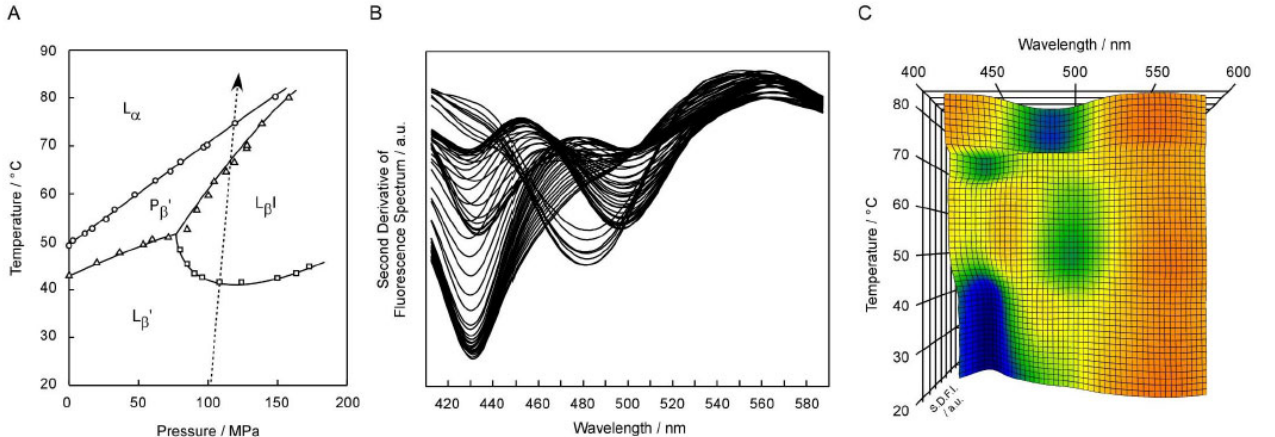
Figure 1. ( A ) Temperature ( T )–pressure ( P ) phase diagram of the C17PC bilayer membrane. ( B ) Second derivatives ( ∂ 2 F ( λ )/ ∂ λ 2 ) of the original spectra F ( λ ) obtained directly from Prodan fluorescence measurements for C17PC bilayer membrane. ( C ) Spectral 3D imaging plot for C17PC bilayer membrane constructed by stacking all the second derivative spectra shown in ( B ). This figure was reproduced with some modification from our previous studies [9,22].